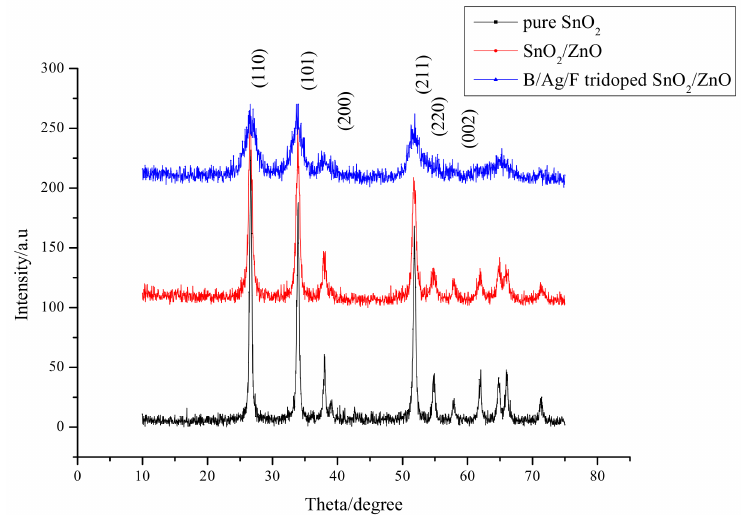
Figure 6. XRD patterns of pure SnO 2 , SnO 2 -ZnO, and B/Ag/F tridoped SnO 2 -ZnO samples heated at 550 ◦ C in atmosphere for 1